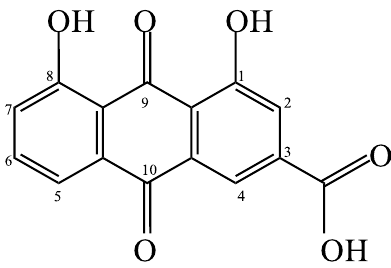
Figure 1. Structure of rhein.